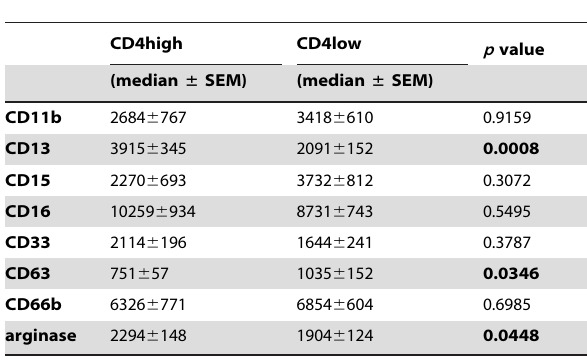
Table 2. Phenotype of